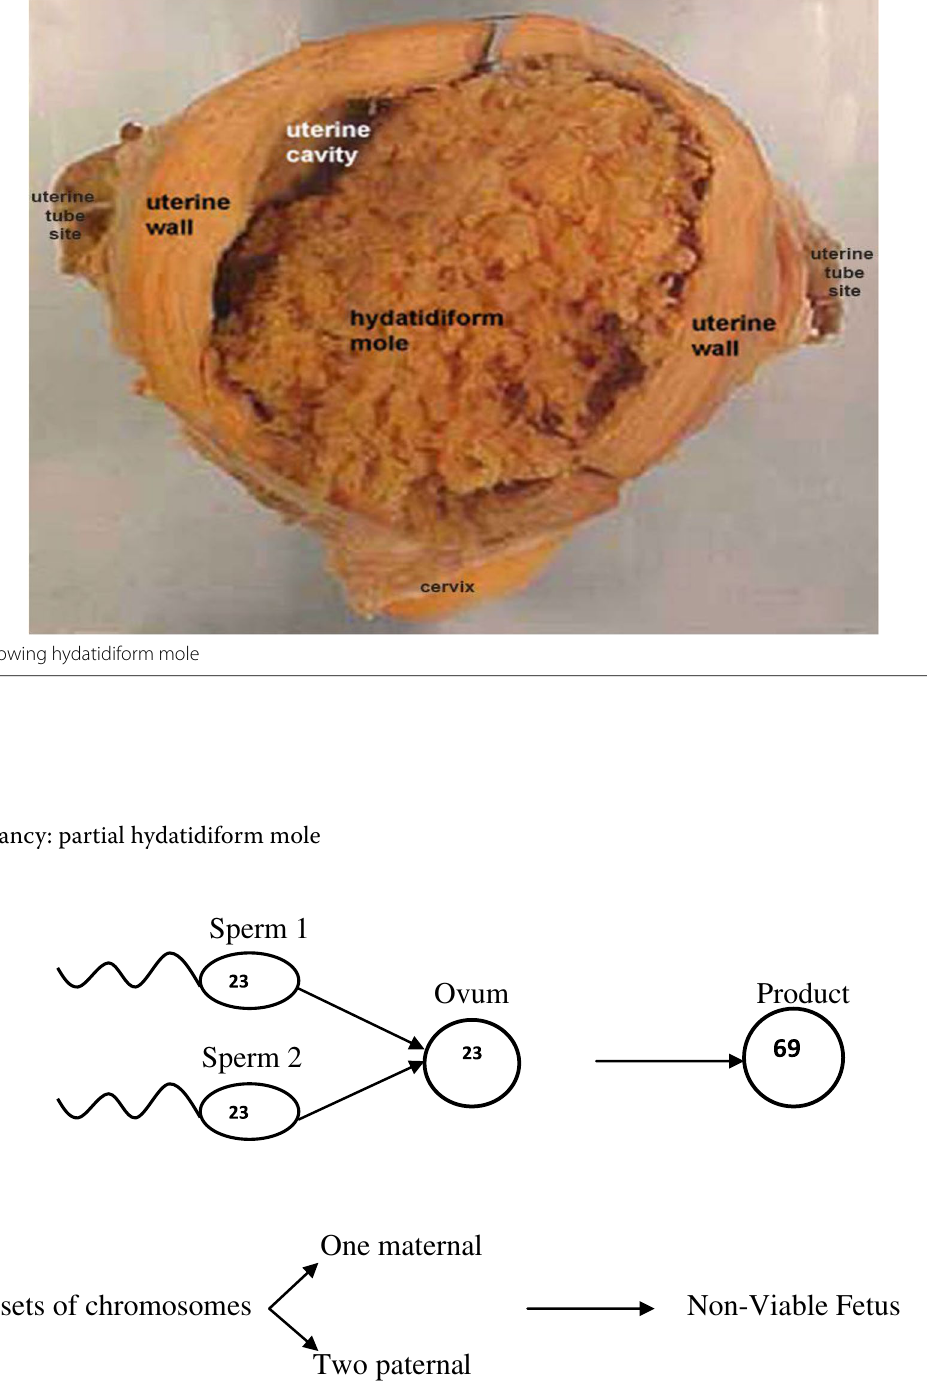
One maternal Three sets of chromoso mes Non-Viable Fetus Two